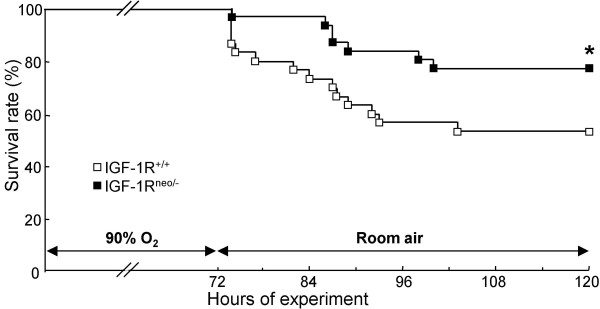
Survival rate following exposure to 90% oxygen. The survival times of IGF-1R+/+ mice (male: n = 15; female: n = 15) and IGF-1Rneo/- mice (male: n = 16; female: n = 15) were measured following exposure to 90% oxygen. Data are expressed as percentage of mice alive at each time point. The asterisk indicates significant differences between IGF-1R+/+ and IGF-1Rneo/- mice, as determined by Kaplan-Meier analysis; P < 0.05.